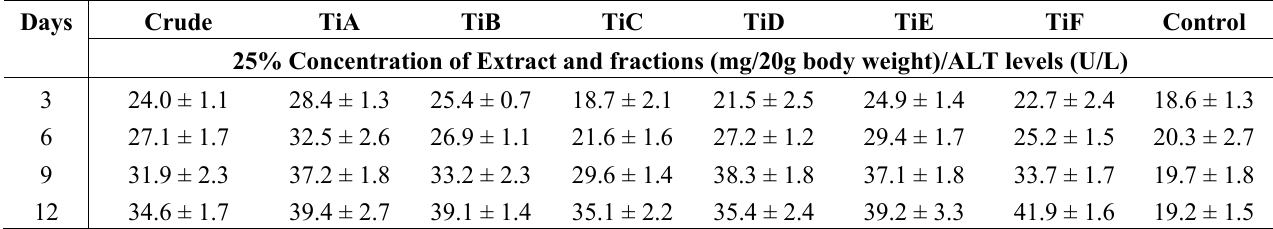
Table 9. Alanine aminotransferase concentration at T . indica dosage over